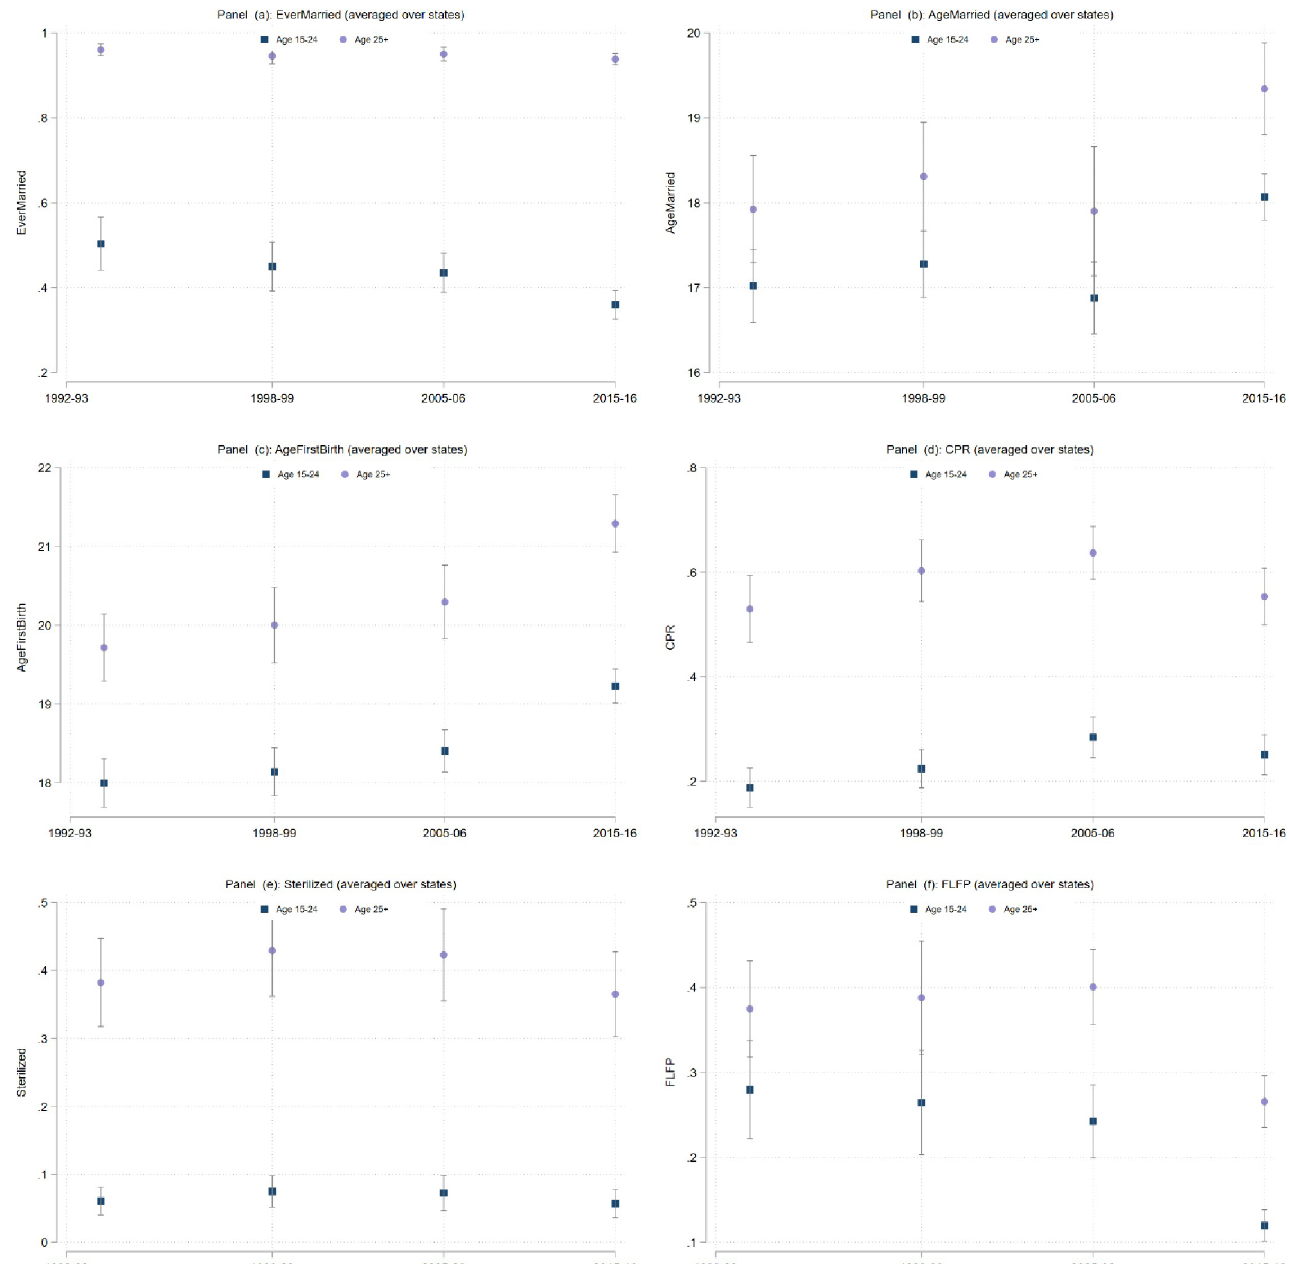
Fig 1. Average values and dispersion across states, by age-group and survey round. https://doi.org/10.1371/journal.pone.0242876.g001 Fig 1, panel (a) suggests that marriage is almost universal in all the states of India through- out the sample period. In the average state, nearly 100% of women aged 25+ are currently mar- ried. Among the younger cohort however, the marriage rates are lower, and have been declining over successive rounds of the survey. In 1991, more than 50 percent of women aged 15–24 were married, but in 2015 this declined to less than 40 percent. In Fig 3, we see the actual estimates at the state level for all four rounds of the survey. Note that in 1991, with the